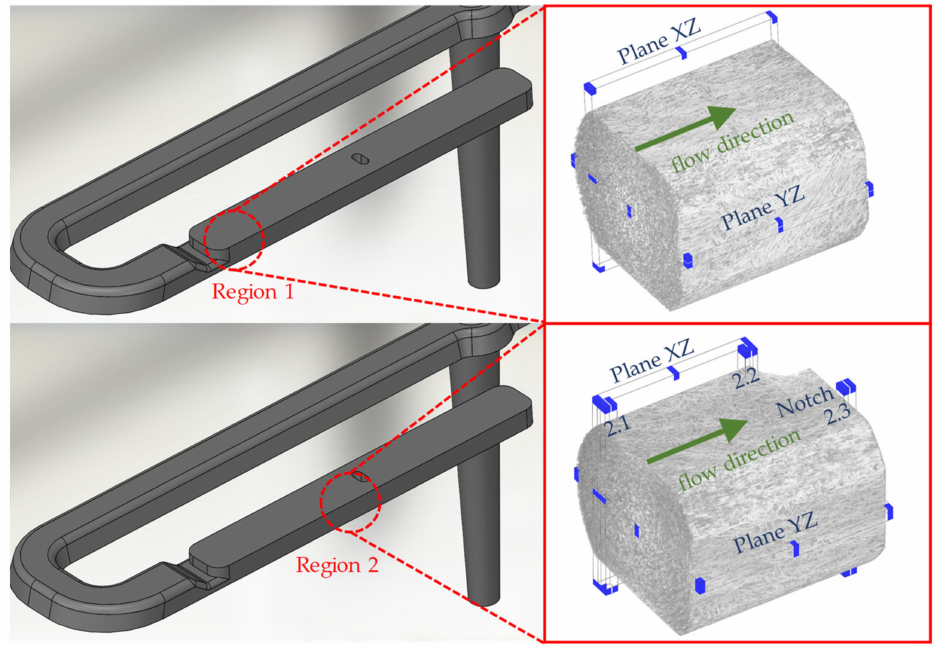
Figure 4. Raw data of 3D µ CT images in regions 1 and 2 with underlying